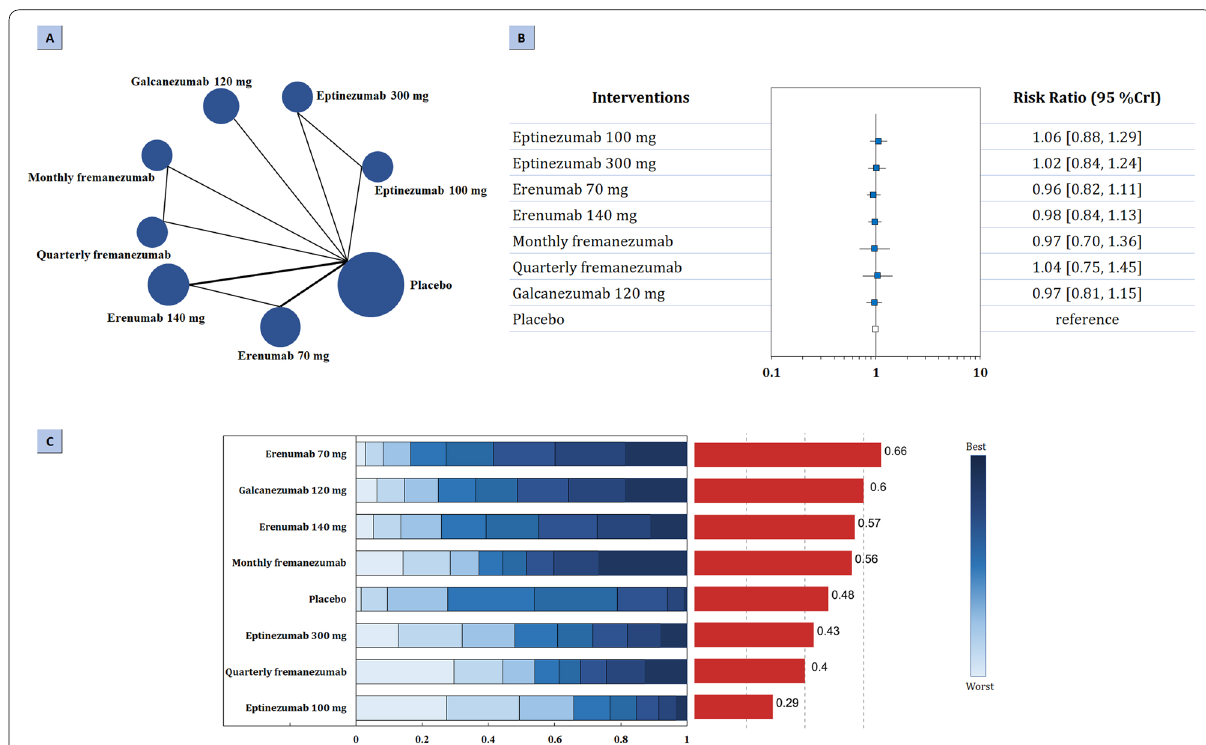
Fig. 3 Summary of the primary safety outcome. A Network plot of change in TEAEs. The width of the lines is proportional to the number of studies comparing every pair of treatments, and the size of each circle is proportional to the number of participants. B The forest plot shows the risk ratio (RR) and credible interval (CrI). C Ranking probabilities graph (blue bars) of each treatment agent. The SUCRA values (red bars) for each treatment are as follows: 66% for erenumab 70 mg; 60% galcanezumab 120 mg; 57% erenumab 140 mg; 56% for monthly fremanezumab; 48% for placebo; 43% for eptinezumab 300 mg; 40% for quarterly fremanezumab; 29% for eptinezumab 100 mg. TEAEs: treatment-emergent adverse events; SUCRA: surface under the cumulative ranking